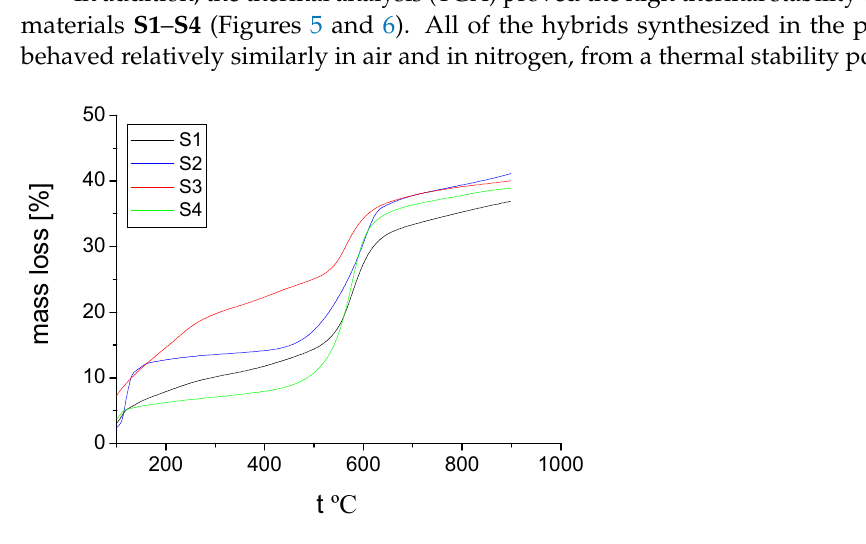
Figure 5. Mass loss (%) resulted from TGA in air for the synthesized hybrid compounds S1–S4